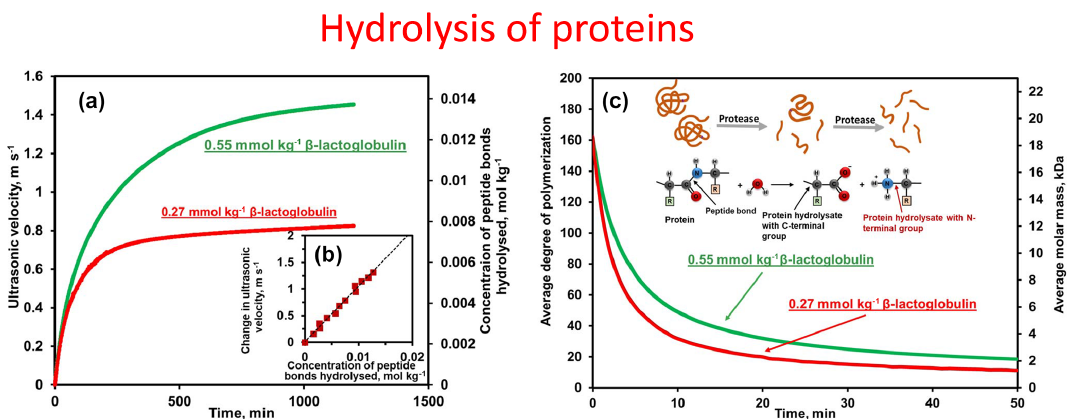
Figure 3. Real-time non-destructive ultrasonic monitoring of hydrolysis of globular protein β -lactoglobulin by enzyme α -chymotrypsin; β - lactoglobulin, 0.55 and 0.27mmolkg − 1 in 0.1M potassium phosphate buffer, pH 7.8, at 25 ◦ C catalysed by α -chymotrypsin from bovine pan- creas, 0.01% w/w . HR-US 102P ultrasonic spectrometer (Sonas Technologies Ltd. Dublin). For more experimental details and data analysis see Buckin and Altas (2017). (a) Time profiles of ultrasonic velocity at 15MHz frequency and of concentration of peptide bonds hydrolysed. (b) Calibration of ultrasonic velocity vs. the concentration of peptide bonds hydrolysed as determined by the 2,4,6-Trinitrobenzenesulfonic acid (TNBS) method following the Adler-Nissen protocol (Adler-Nissen, 1979). (c) Evolution of average degree of polymerization and molar mass of β -lactoglobulin during hydrolysis calculated from the time profiles of ultrasonic velocity (see Buckin and Altas, 2017, for details).